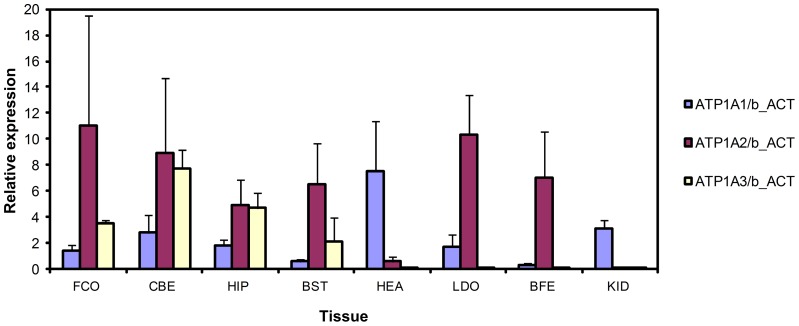
Comparative expression levels of porcine ATP1A1, ATP1A2, and ATP1A3 mRNA in different organs and tissues from adult pigs.
β-actin (b_ACT) is used as endogenous reference. Each column represents the mean expression of a triplicate from three different pigs. The considerable biological variation between the animals represented in each column is indicated by error bars showing the standard deviation. FCO: frontal cortex, CBE: cerebellum, HIP: hippocampus, BST: brain stem, HEA: heart, LDO: longissimus dorsi, BFE: biceps femoris, KID: kidney.